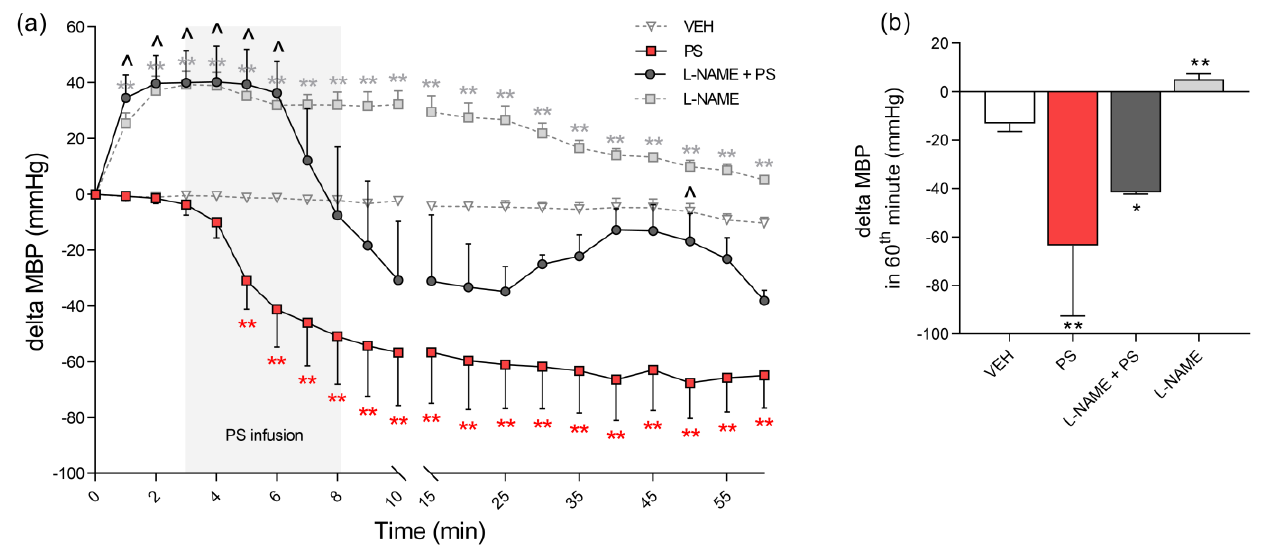
Figure 12. The effects of protamine sulfate (PS) alone and together with N( ω )–nitro– L –arginine methyl ester ( L –NAME) on mean blood pressure (MBP). The course of MBP was tracked for 60 min after short–duration intravenous infusion (5 min; 2 mL/h) of PS (15 mg/kg) following intravenous administration of vehicle (VEH; 1 mL/kg) or L –NAME (25 mg/kg; 1 mL/kg). Results are shown as means (line) with SEMs ( a ) and as medians with ranges ( b ). The MBP values at 0 min of the experiment were 121.4 (86.6–138.0) for VEH, 139.3 (130.4–153.3) for PS 15 mg/kg, 124.9 (107.1–119.8) for PS 10 mg/kg + L –NAME, and 132.5 (118.5–138.9) for L –NAME alone. Note: * p < 0.05, ** p < 0.01 vs. VEH, ˆ p < 0.05 vs. PS 15 mg/kg, Kruskal–Wallis ANOVA with Dunn’s post–hoc test, n = 3–5.